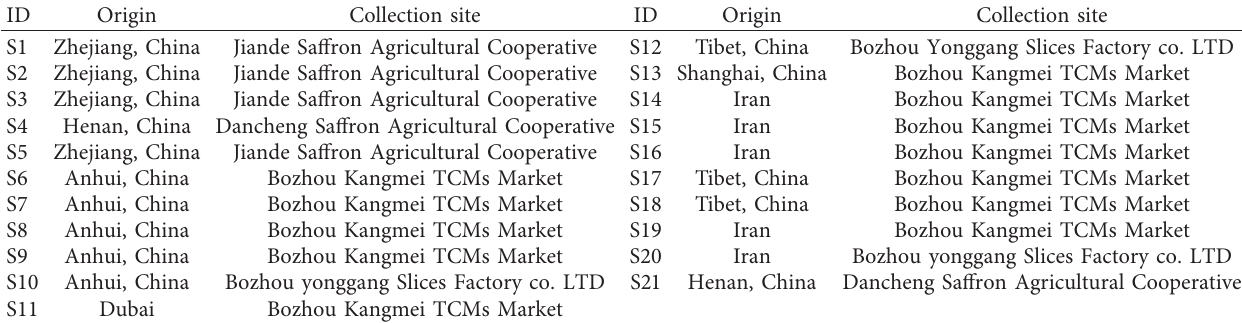
Table 1: The origin and collection sites of 21 batches of saffron used in this